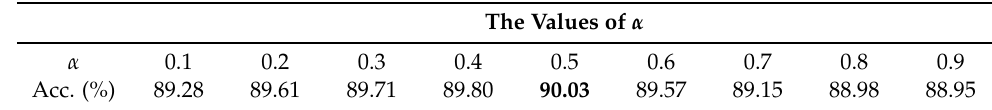
Table 4. Evaluation of different α values on the RAF-DB dataset. When setting α = 0.5, the perfor- mance is the best.